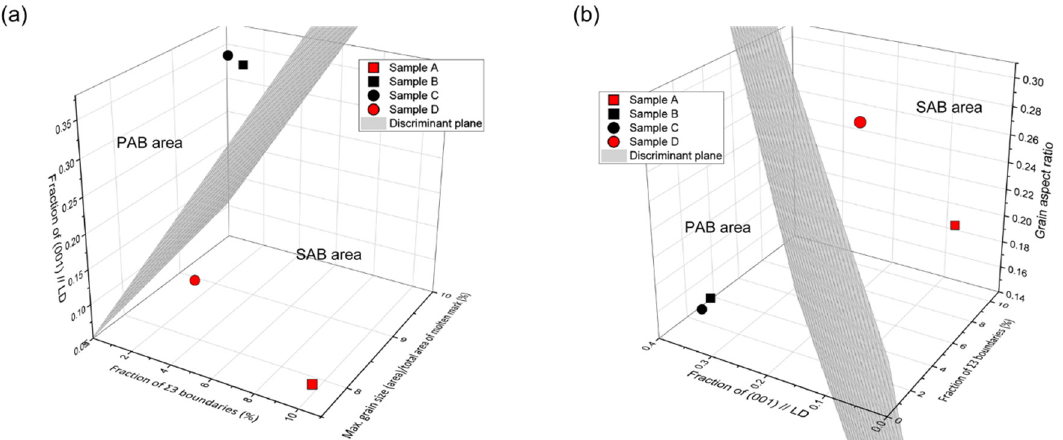
Figure 13. Distribution of the molten marks collected from the fire sites: ( a ) Sig3–GS–CD and ( b )